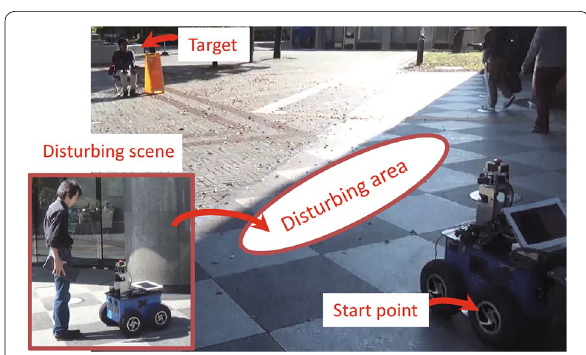
Fig. 25 Experimental setting with navigation target and